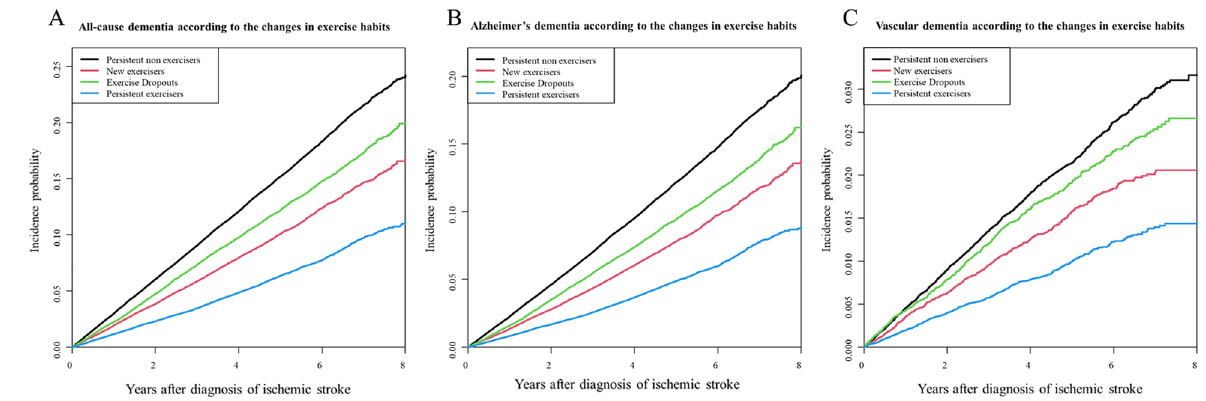
Figure 3. Incidence probability of all-cause dementia ( A , p < 0.001), Alzheimer’s dementia ( B , p < 0.001), and vascular dementia ( C , p < 0.001) after ischemic stroke according to to change of physical activity habits.